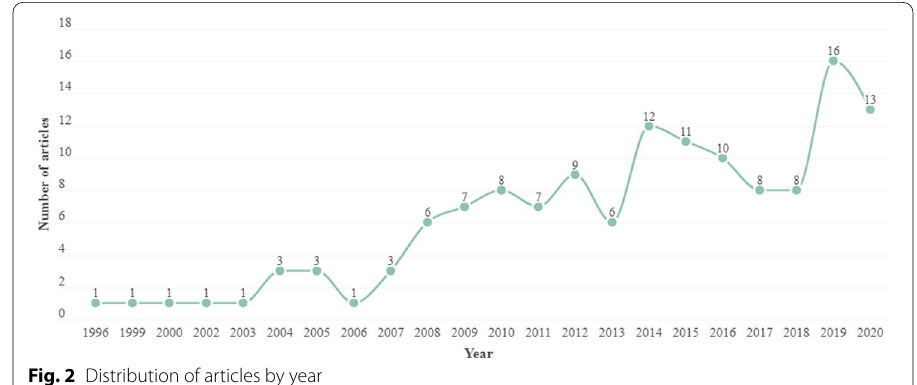
Fig. 2 Distribution of articles by year